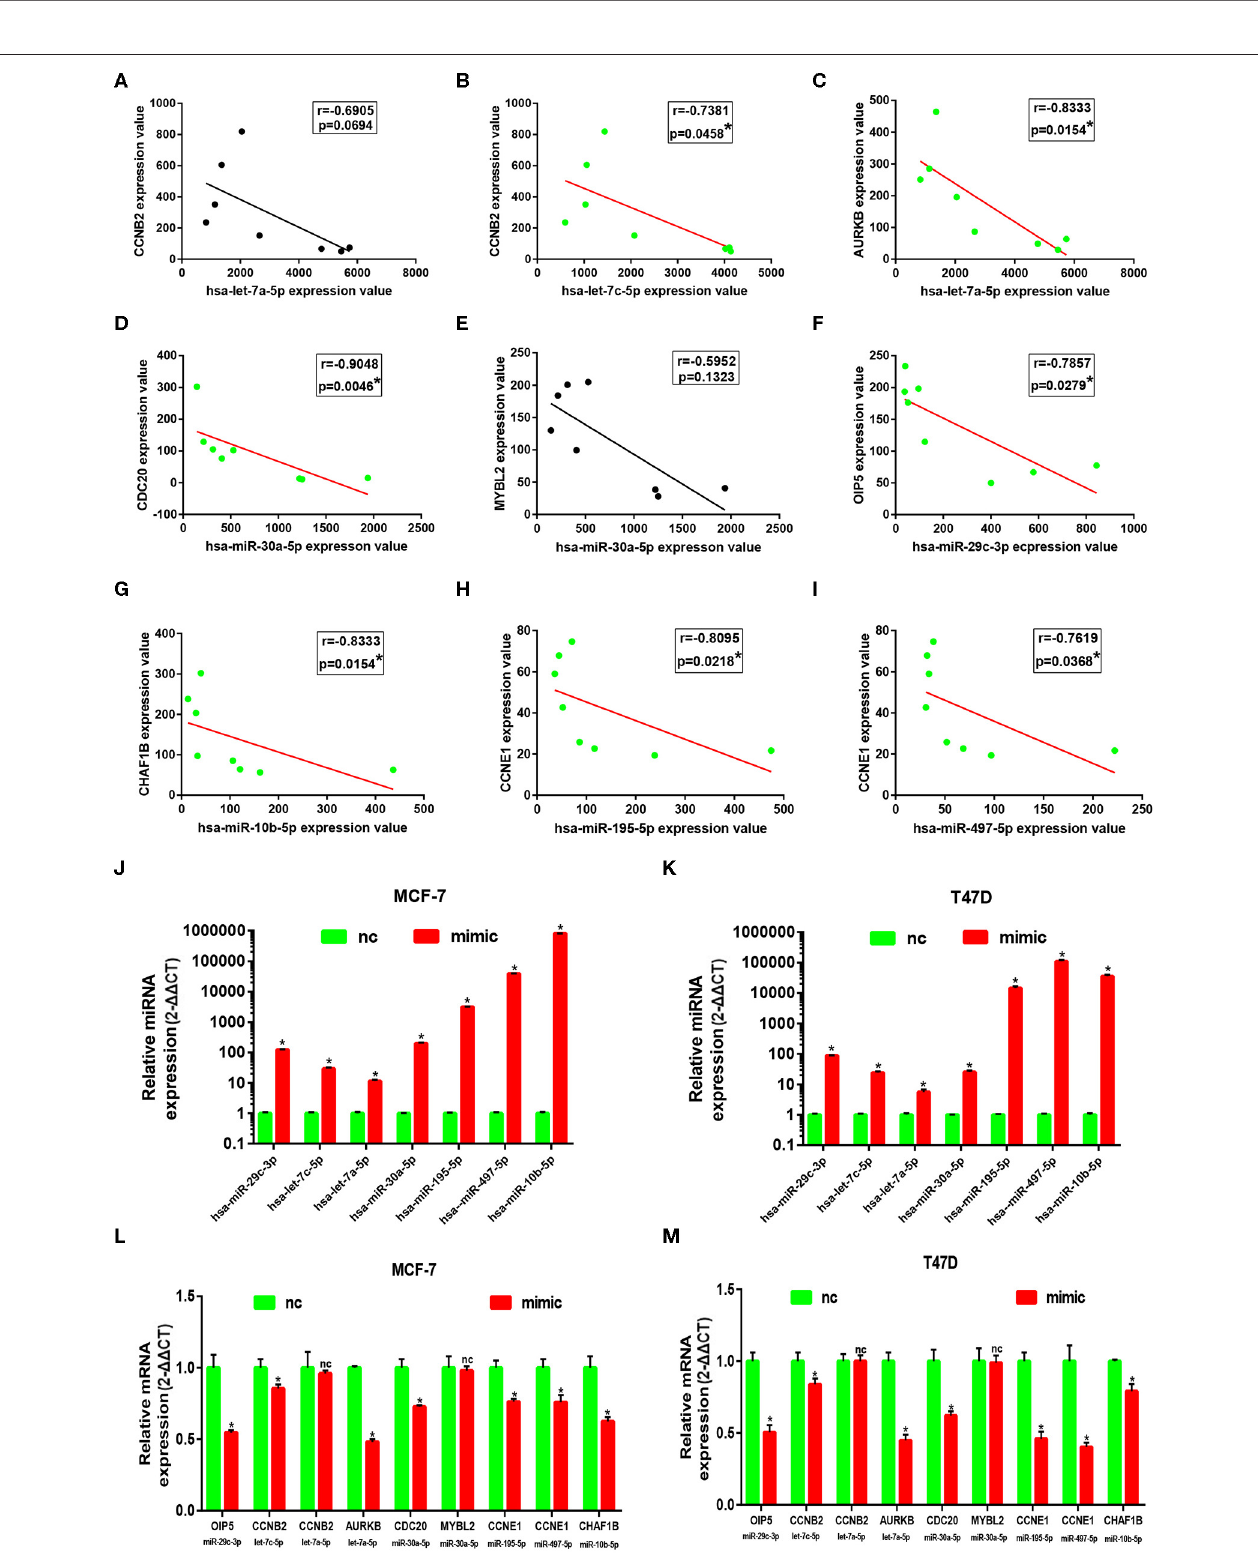
FIGURE 7 | Identification of downstream genes of 7 key miRNAs in ER α positive breast cancer. (A) The correlation analysis of CCNB2 expression and hsa-let-7a-5p expression. (B) The correlation analysis of CCNB2 expression and hsa-let-7c-5p expression. (C) The correlation analysis of AURKB expression and hsa-let-7a-5p expression. (D) The correlation analysis of CDC20 expression and hsa-miR-30a-5p expression. (E) The correlation analysis of MYBL2 expression and hsa-miR-30a-5p